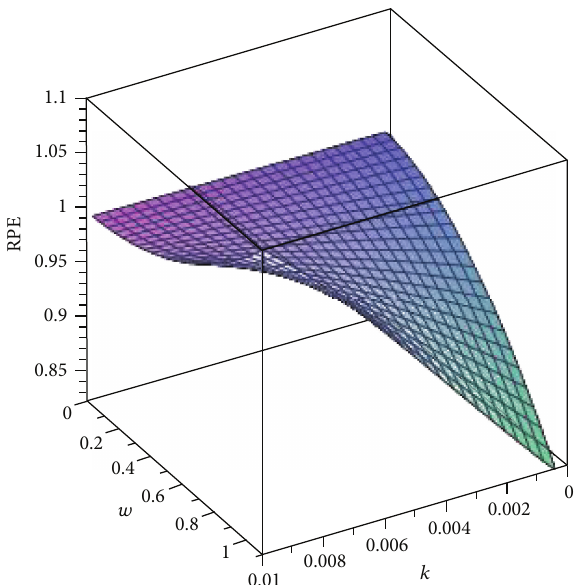
Figure 10: Plot of RPE versus 𝑘 versus 𝑤 for the NSFD scheme at ℎ = 0.02 .